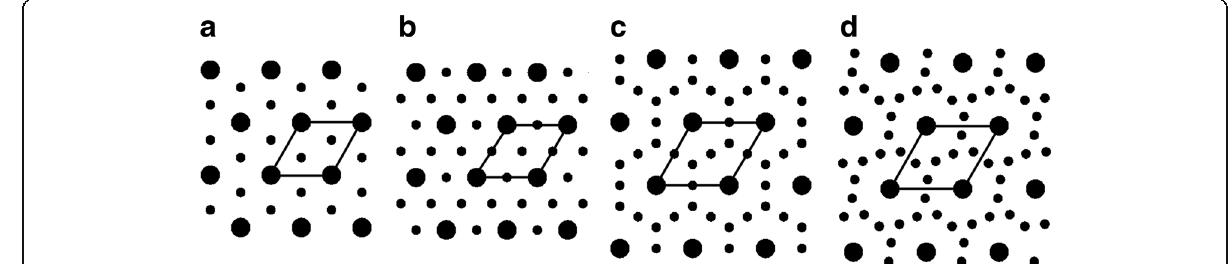
Fig. 2 Types of myofilament lattice of muscle. a 1:2 lattice (the myosin-to-actin filament number ratio is 1:2), seen in vertebrate skeletal and cardiac muscles. b 1:3 lattice, seen in insect flight muscles. c 1:5 lattice; d 1:6 lattice. These are seen in non-flight muscles of insects and in muscles of other arthropods. See also [19, 37]. The larger dots represent the myosin filaments, and the smaller dots, the actin filaments. The area marked by the lines represents the unit cell, which contains one myosin